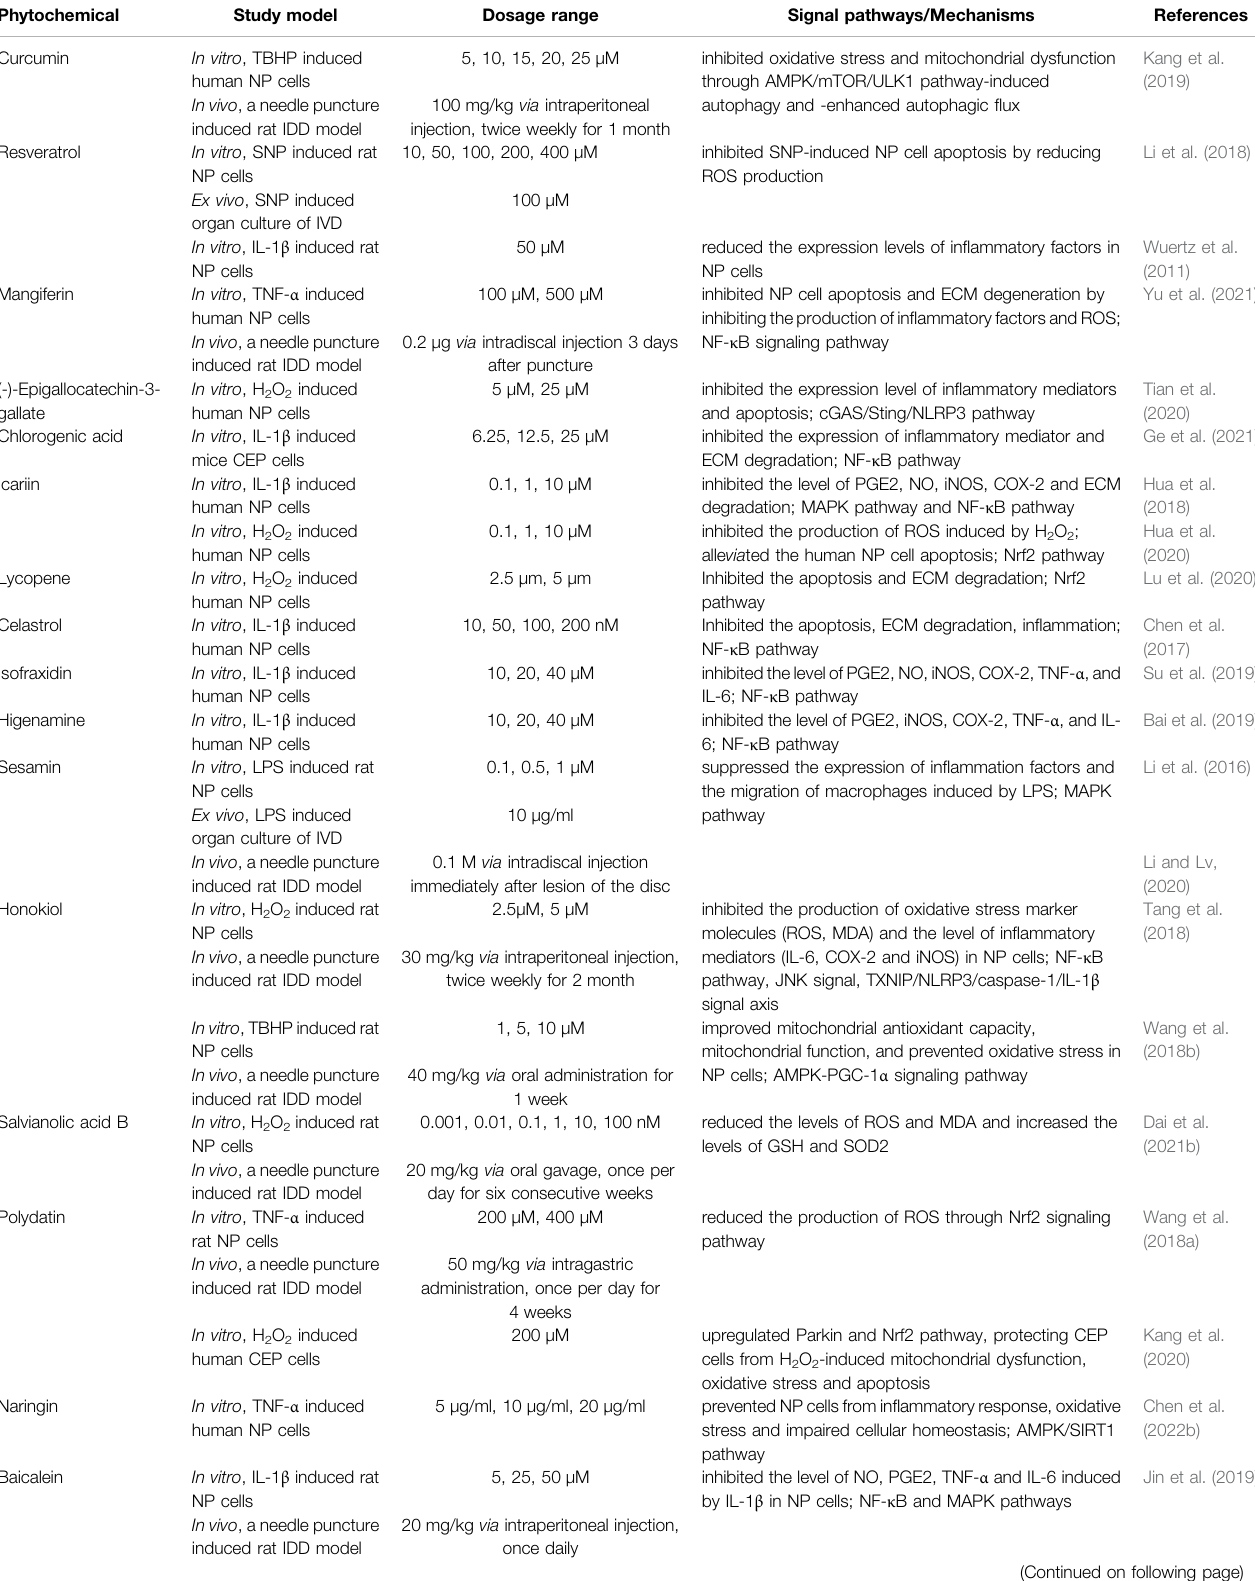
TABLE 1 | Phytochemicals possess multiple pharmacological effects via the anti-in fl ammatory and antioxidant mechanism in various in vitro and in vivo models of